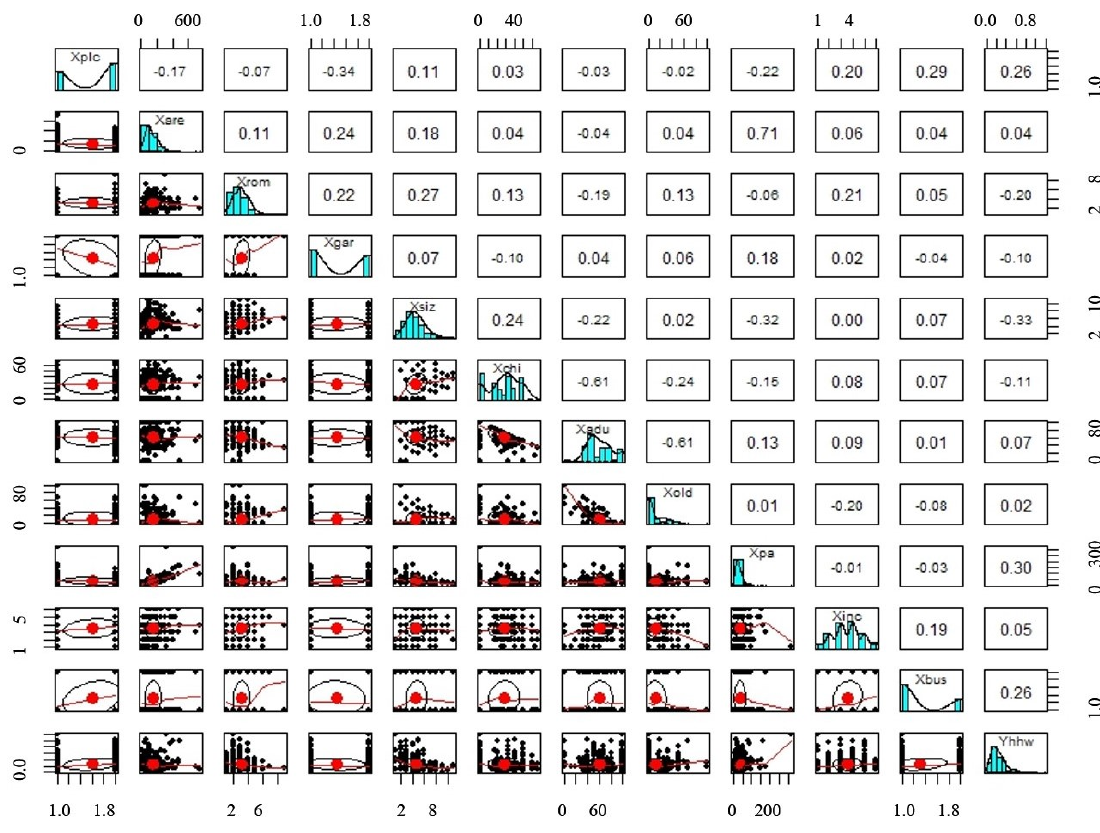
Fig. 2: Correlation coefficients of the variables